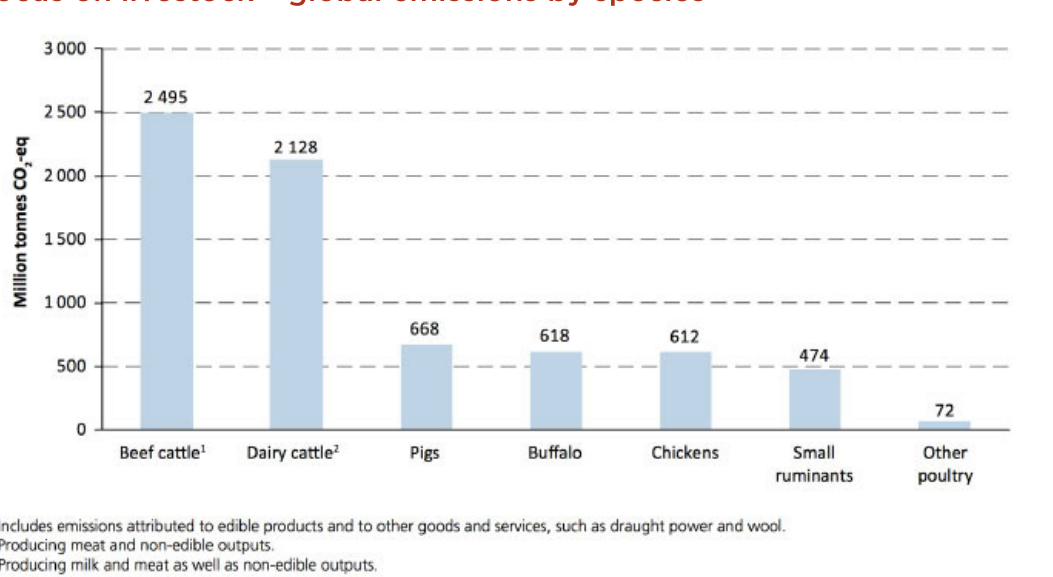
FIgure 8: Total greenhouse gas emissions by livestock species. Source: Gerber, et al .